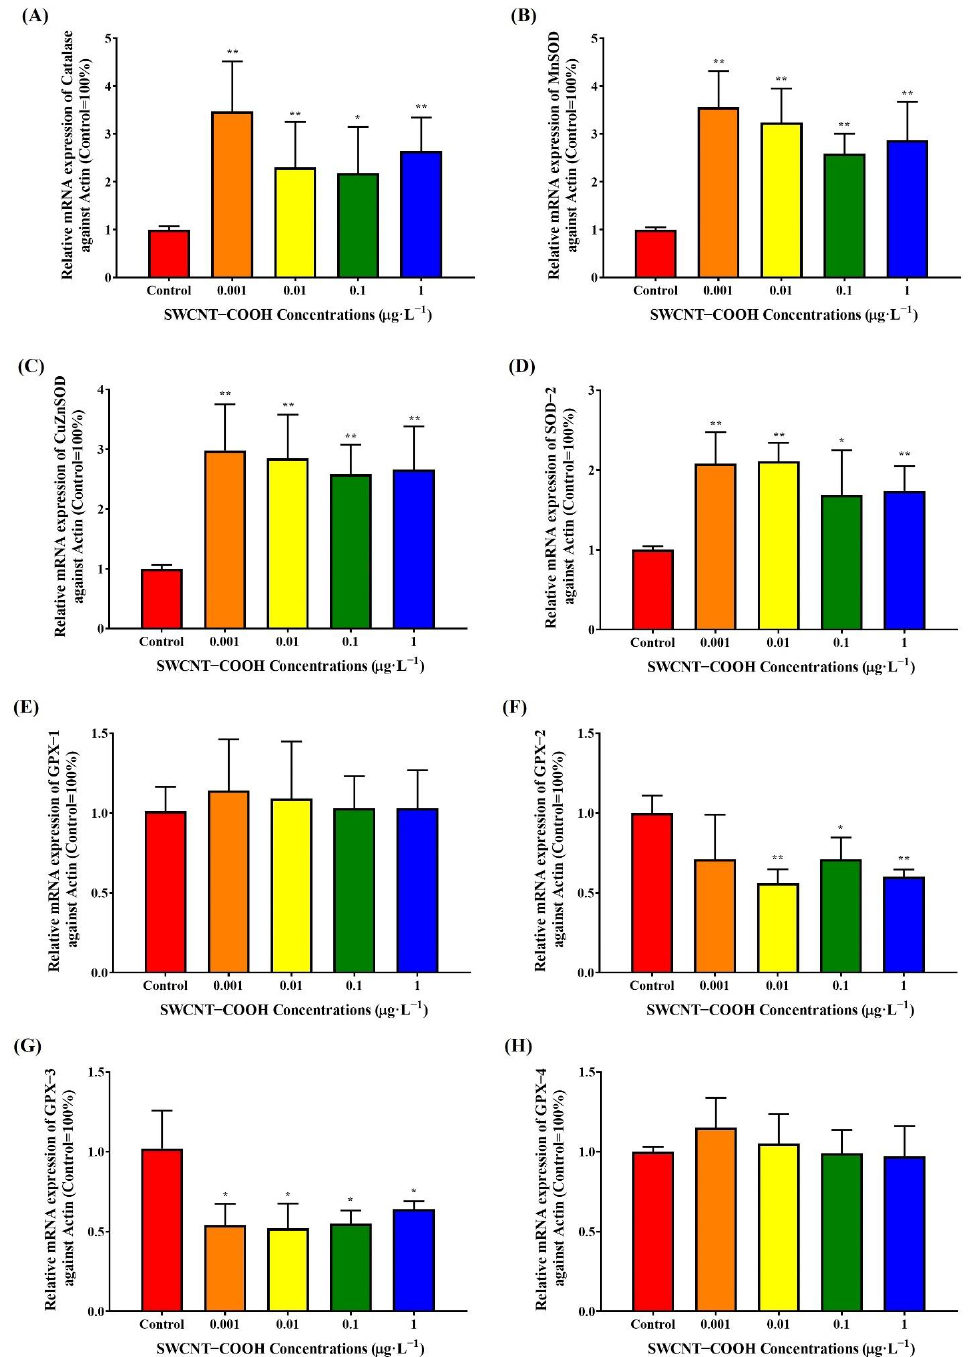
Figure 8. Effects of SWCNTs − COOH on the mRNA expression of catalase ( A ), MnSOD ( B ), CuZnSOD ( C ), SOD-2 ( D ), GPX-1 ( E ), GPX-2 ( F ), GPX-3 ( G ), and GPX-4 ( H ) in THP-1 cells after 48 h of exposure. * p < 0.05; ** p < 0.01 as compared with the